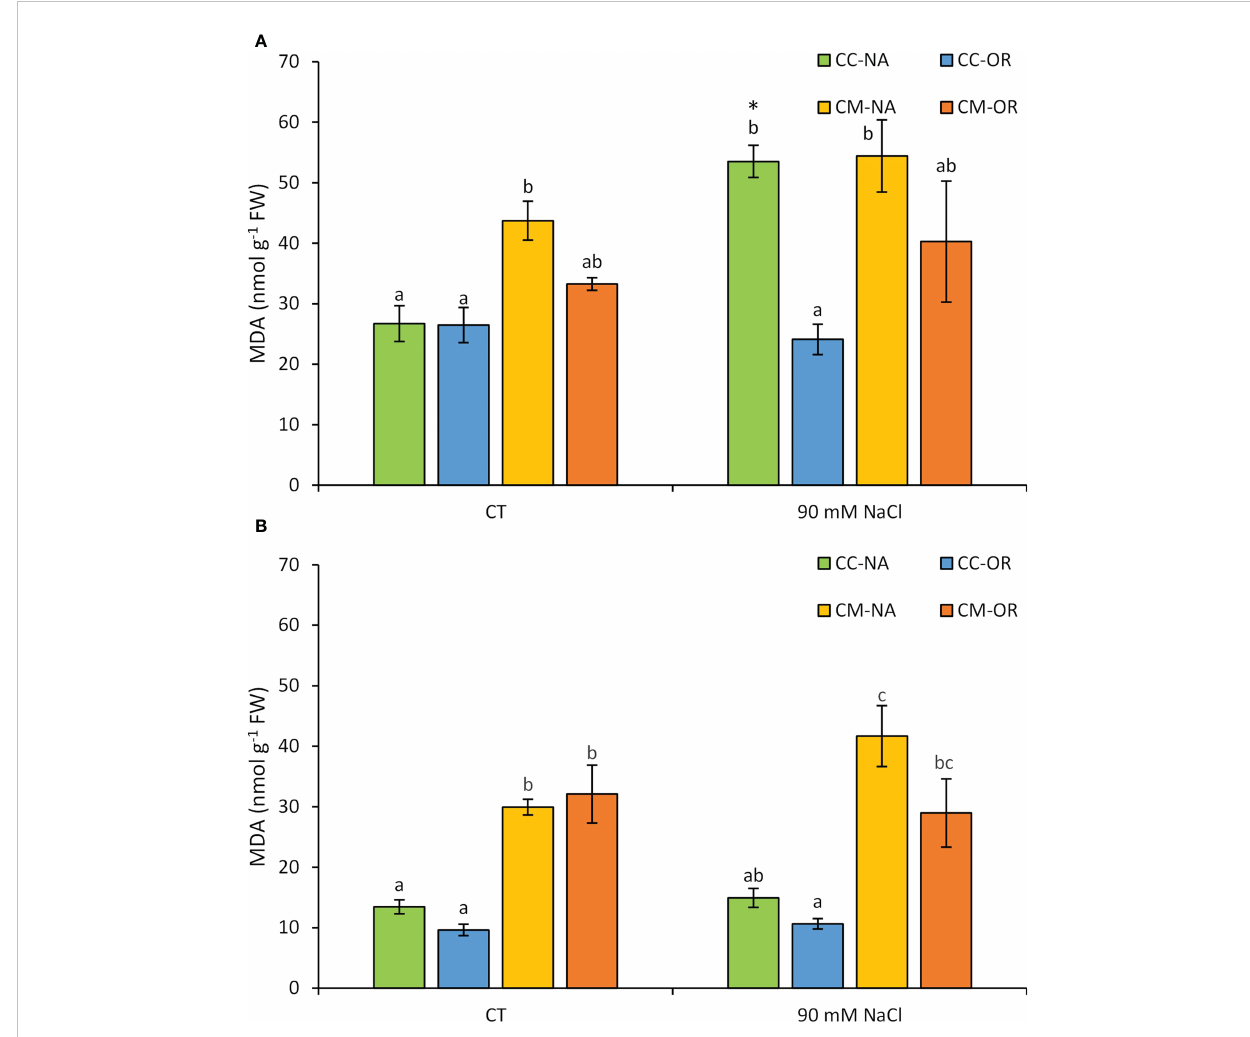
FIGURE 1 Leaf (A) and root (B) malondialdehyde content. Malondialdehyde content in leaves and roots of control and salt-stressed plants of CC-NA (green bars), CC-OR (blue bars), CM-NA (yellow bars), and CM-OR (orange bars) after 30 days. Values are the mean of three replicates ± standard error. Asterisks denote statistically signi fi cant differences in the stressed plants related to control at p ≤ 0.05. Different letters denote statistically signi fi cant differences among the rootstock/scion combinations for each treatment at p ≤